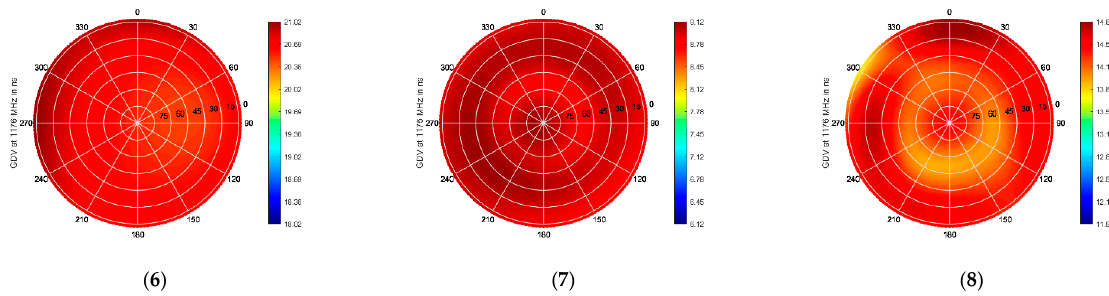
Figure A6. Group delay in ns at L5/E5a central frequency of the antennas measured at DLR; from left to right, from top to bottom: ( 1 ) Leica AR25 R4; ( 2 ) Novatel GNSS-750; ( 3 ) Javad RingAnt-DM; ( 4 ) Space Engineering GalExpAnt; ( 5 ) DLR internal design; ( 6 ) Novatel 703-GGG; ( 7 ) Navxperience Nav3G+C; ( 8 ) Tallysman VSE6028 VeroStar.